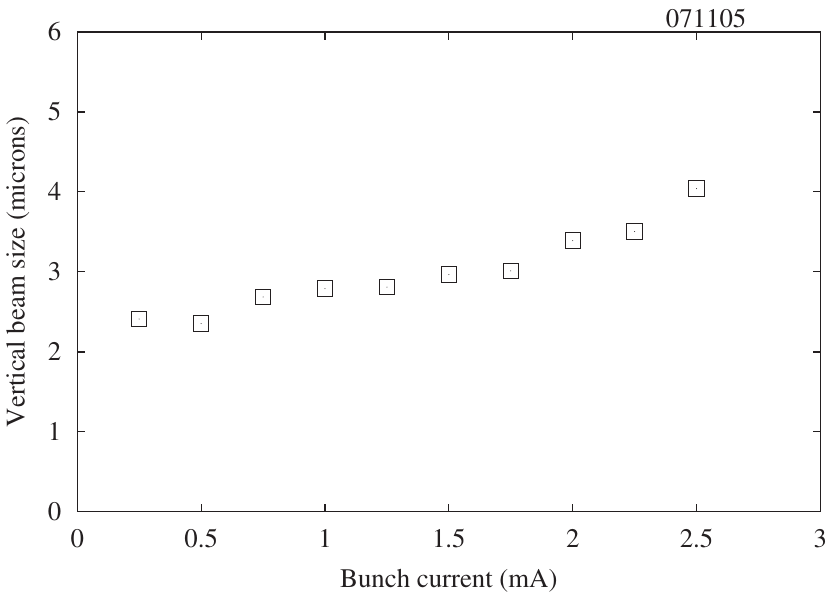
FIG. 12. Fitted vertical beam size of the weak beam distribution yielding the luminosity displayed in Fig.